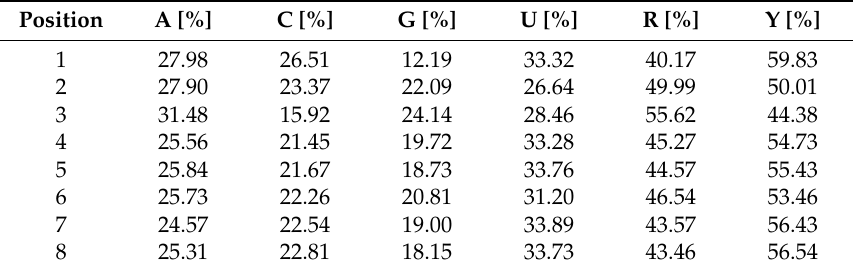
Table 2. WebLogo 3.0 [28] results for vicinity sequences in the VS8-3 ′ subset. Position